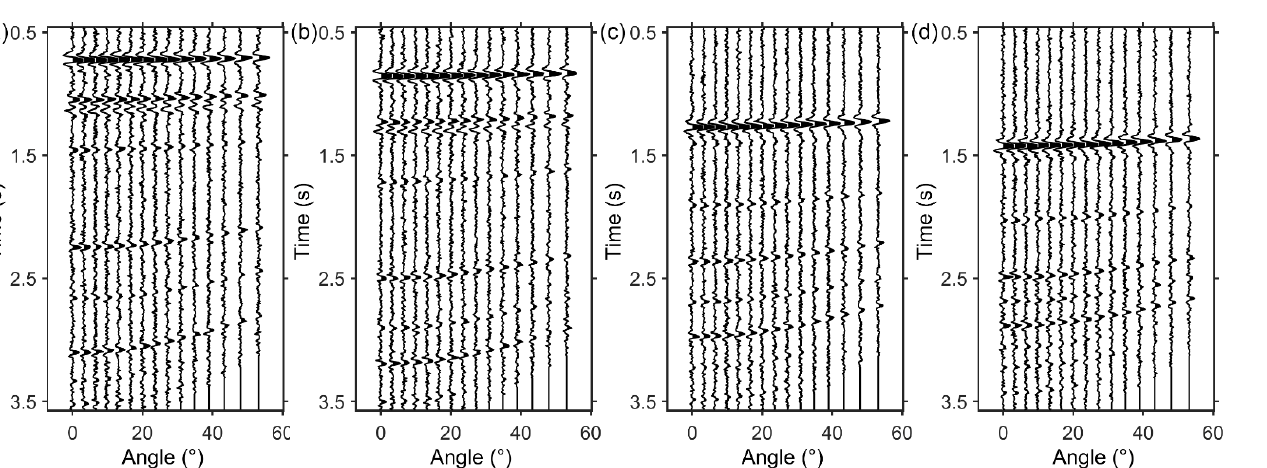
Figure 12. ( a ) Synthetic seismic angle gathers at 2.25 km after the wave-equation-based inversion method, ( b ) difference between the real seismic gather in Figure 3b and synthetic seismic gather in ( a ).